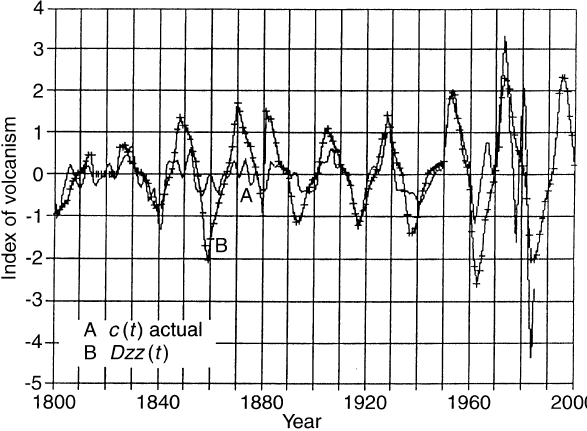
Fig. 20. Global volcanism and